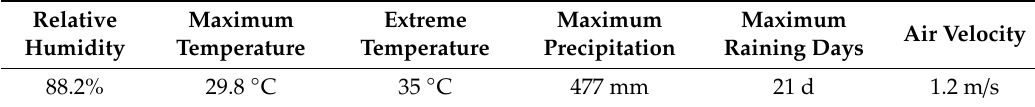
Table 2. Average meteorological parameters for Jinyun County in June